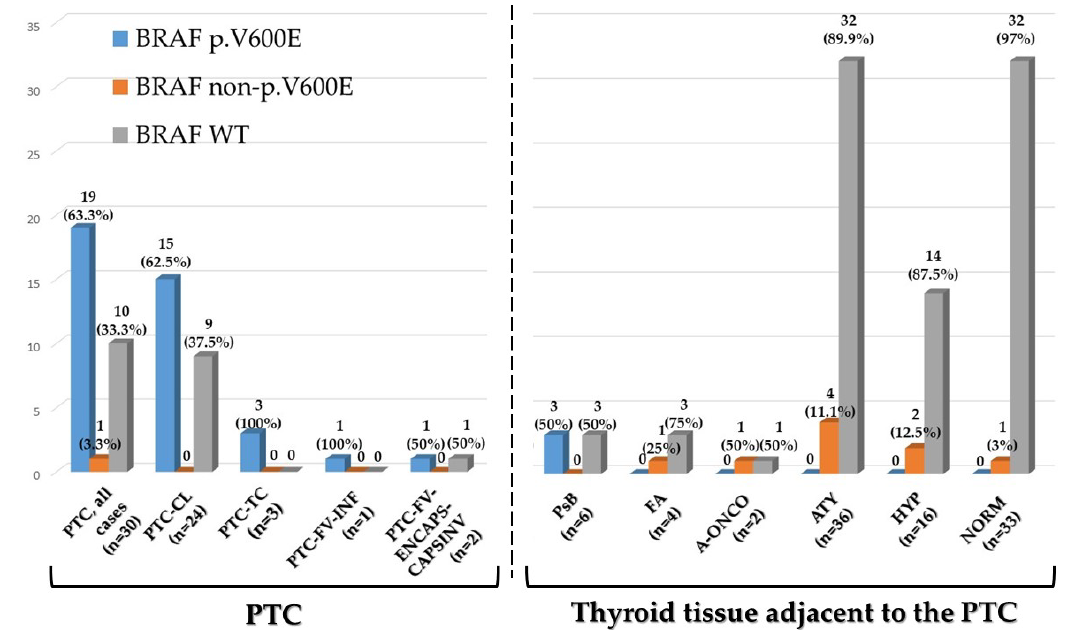
Figure 2. BRAF exon 15 status in thyroid samples. Bars represent the number of samples that are BRAF p.V600E, BRAF non p.V600E mutated, and BRAF wild type (WT). Percentages are in parenthesis. Two separate samples were analyzed from one follicular adenoma for a total of four samples from three follicular adenomas. Two separate samples were analyzed from one oncocytic follicular adenoma. PTC: papillary thyroid carcinoma; PTC-CL: classic PTC; PTC-TC: PTC, tall cell variant; PTC-FV-INF: PTC follicular variant—infiltrative; PTC-FV-ENCAPS-CAPSINV: PTC follicular variant—encapsulated, with capsular invasion; PsB: psammoma bodies; FA: follicular adenoma; FA-ONC: follicular adenoma, oncocytic; ATY: thyroid tissue with follicular cell atypia; HYP: thyroid tissue with follicular cell hyperplasia; and NORM: histologically normal thyroid tissue.